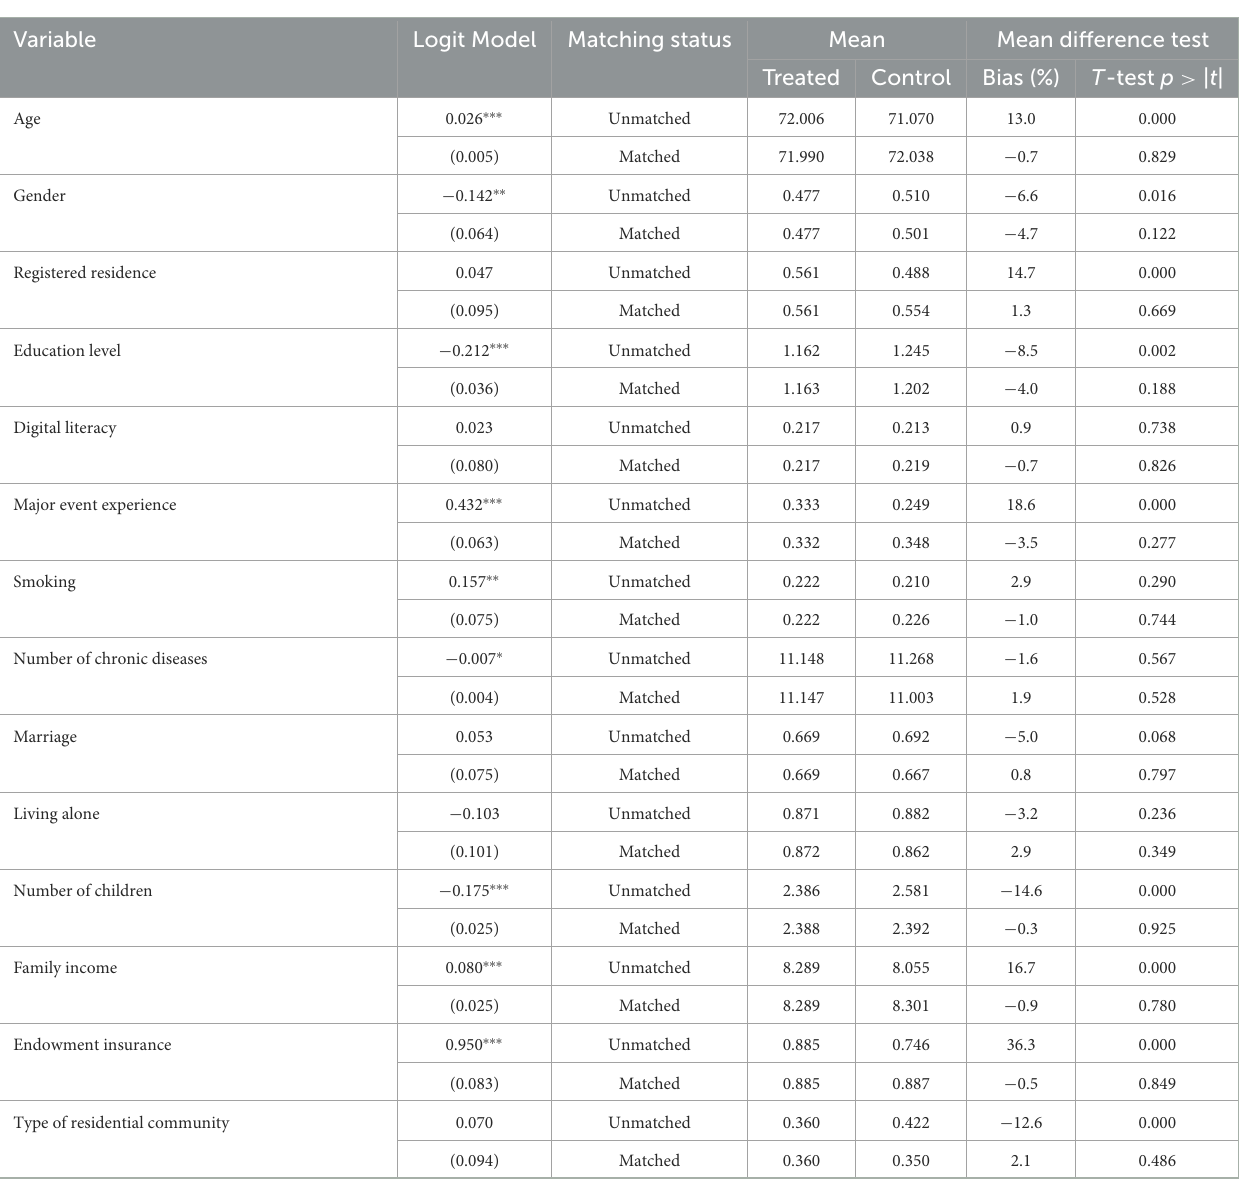
TABLE 2 Balance test